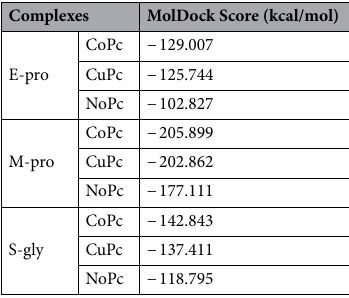
Table 1. MolDock score